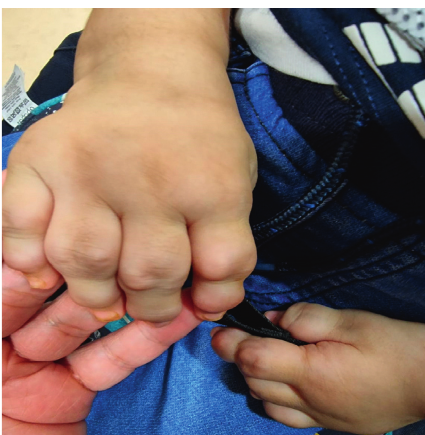
Figure 1: A picture of the patient’s hands showing the swelling and deformities of the interphalangeal